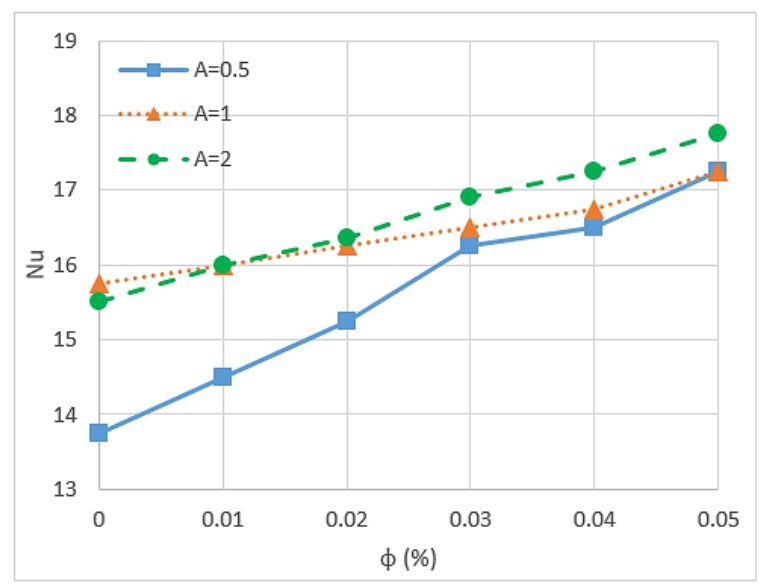
Micromachines 2020 , 11 , x 11 of 19 Figure 6. Nusselt number for di ff erent aspect ratios and various volume fractions with Ra = 10 6 [86]. Figure 6. Nusselt number for different aspect ratios and various volume fractions with Ra = 10 6 . [86]